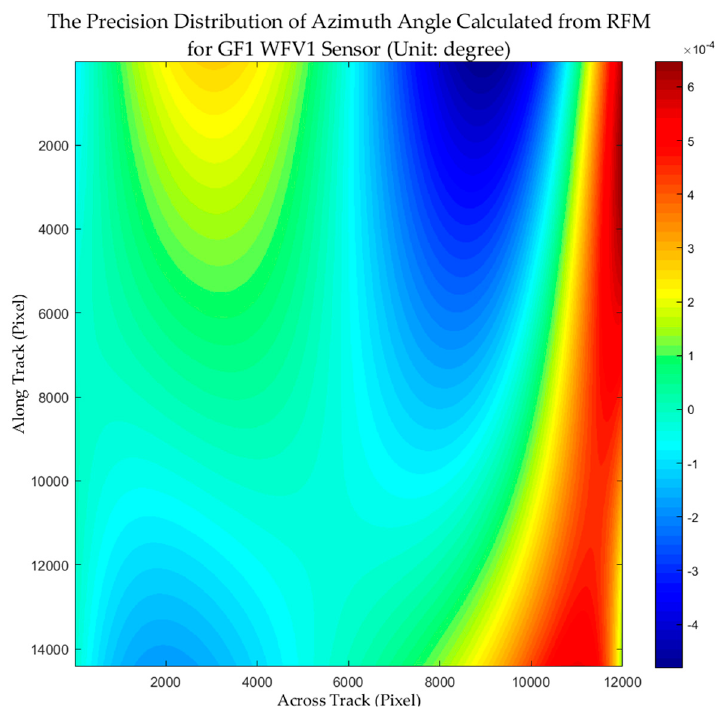
Figure 5. Precision distribution of the azimuth angle calculated from the Rational Function Model (RFM) for Gaofen-1 (GF-1) Wide-Field-View-1 (WFV-1) sensor (unit: degrees).